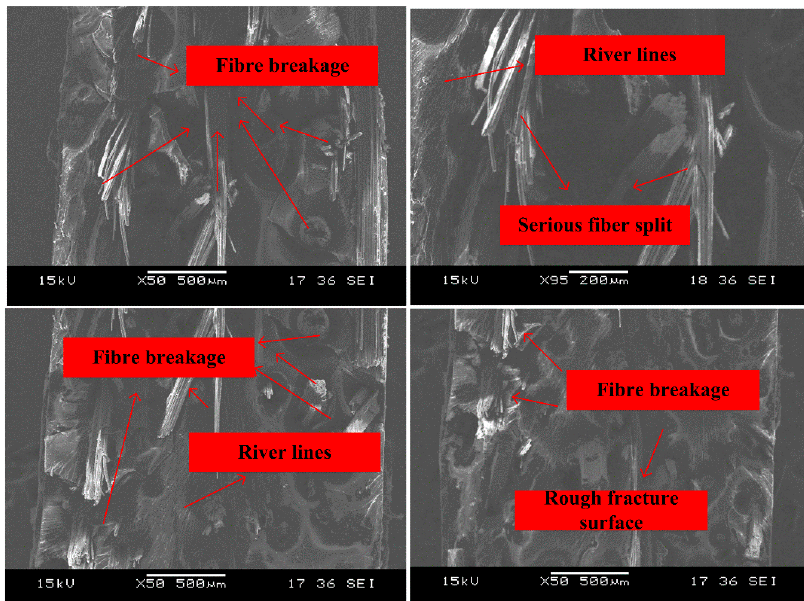
Figure 10. Fracture morphologies of APB under strain rate of 35/s. Under a higher strain rate of 110/s, Figure 11 shows the fracture surface of the specimen became rougher. Matrix cracking, fiber breakage, and split were the main failure modes. It was worth noting that some benzoxazine resin could be observed on the bamboo fibers and this further indicates the interfacial bonding between fibers and the matrix was still very strong at a higher strain rate.